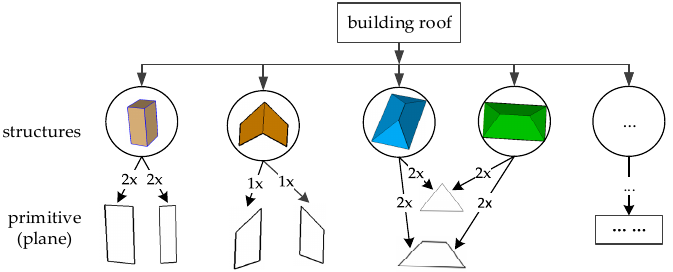
Figure 2. Hierarchy-tree representation of a building roof. A structure, such as a vertical chimney, can be represented as two pairs of parallel planes, while a dormer can be represented as two adjacent planes, and a roof can be combined with a set of planes.